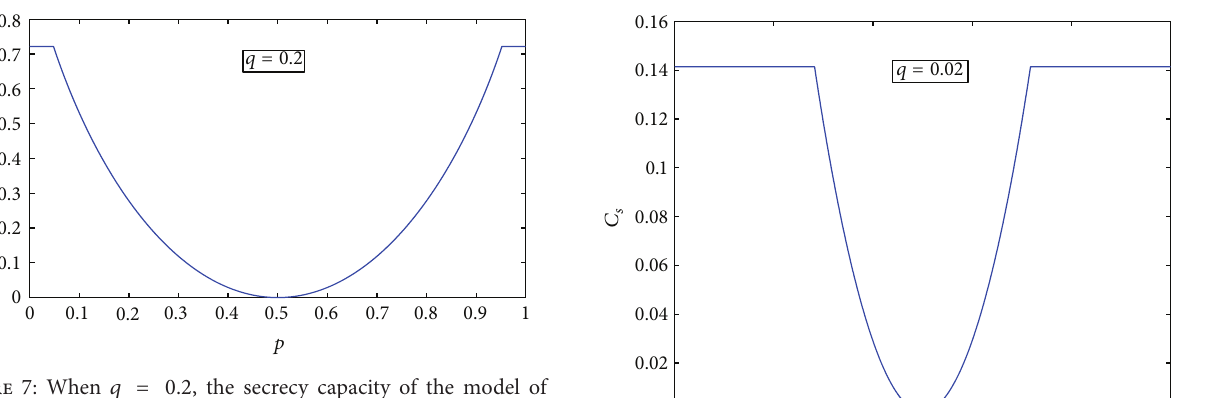
Figure 7: When 𝑞 = 0.2 , the secrecy capacity of the model of Figure 6 is with causal channel state information.